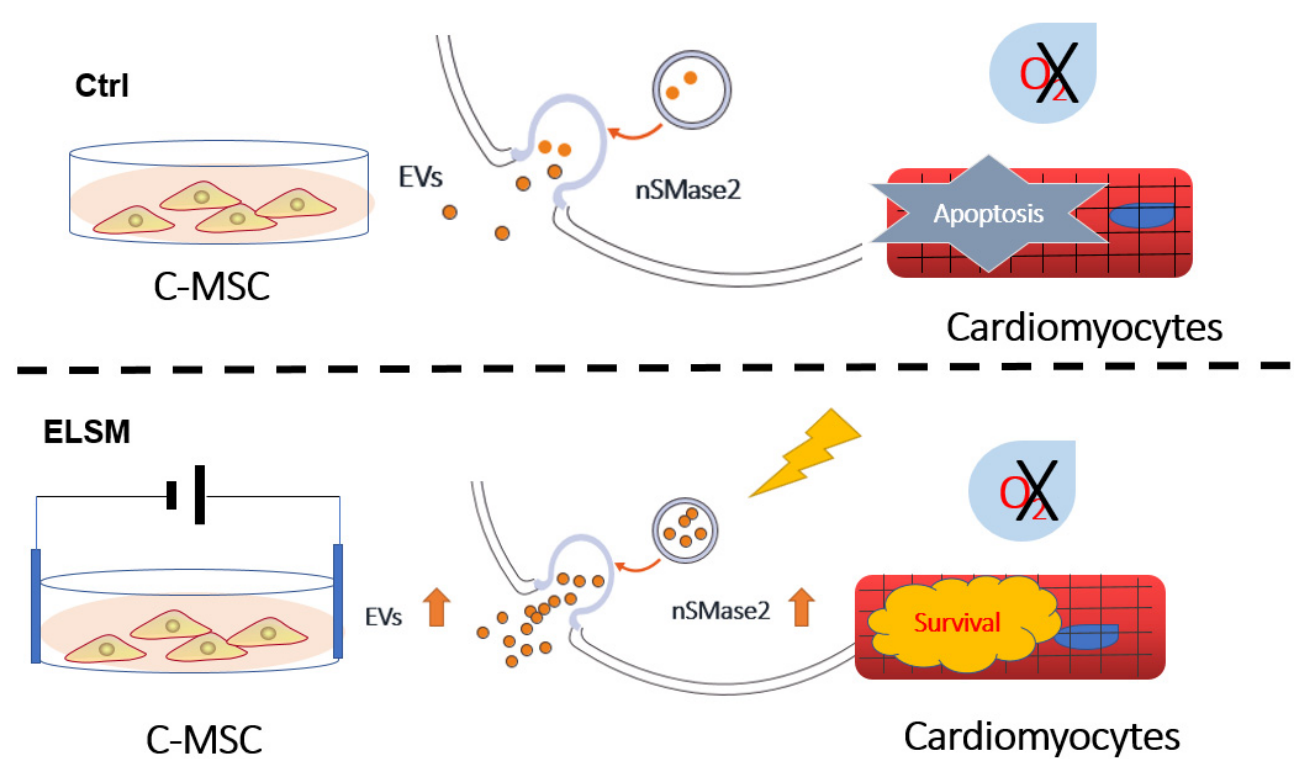
Figure 6. Schematic overview of proposed the mechanisms of ELSM-induced cardiomyocyte pro- tection. ELSM increases expression of nSMase2, leading to increased EV secretion, which protects cardiomyocytes from hypoxia-induced apoptosis.